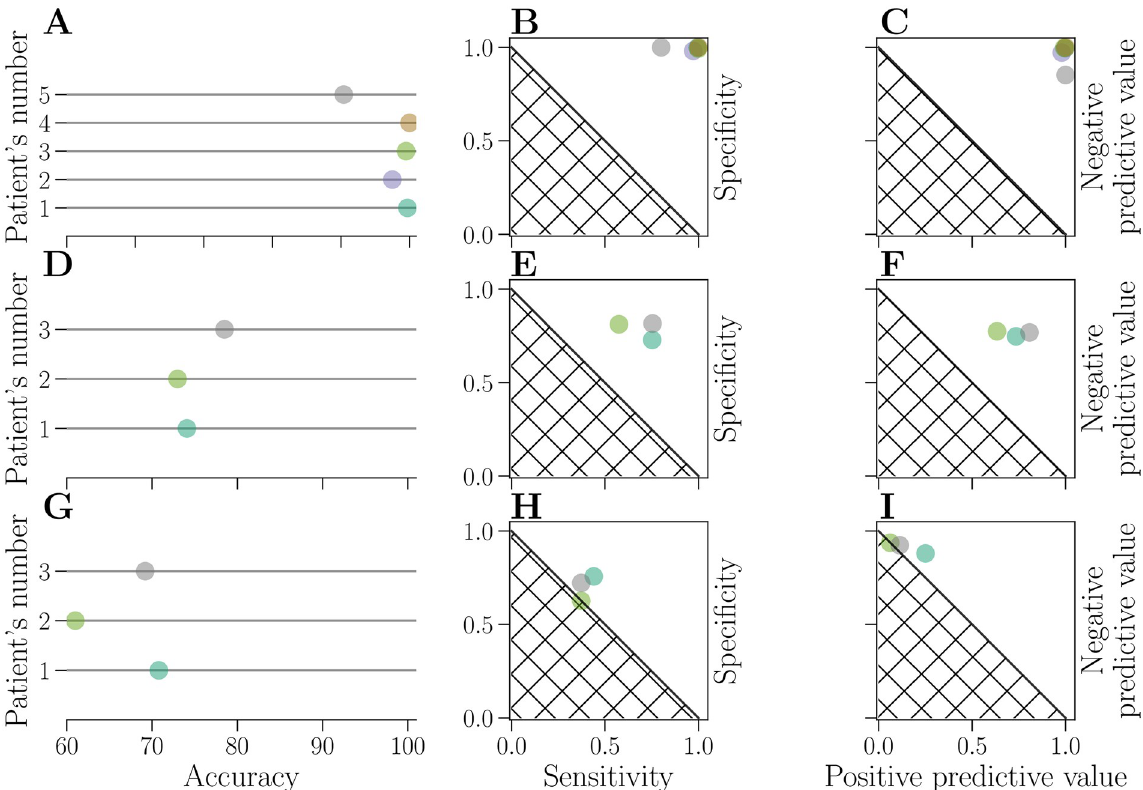
Fig 5. Evaluation of prediction performance. Results on the EPILEPSIAE dataset are shown in the upper row( A-C ). Results on the public Epilepsyecosystem are shown in the middle row ( D-F ) and the results on the private Epilepsyecosystem dataset (benchmark) are shown in the lower row ( G-I ). Performance of each patient is represented by a circle, for accuracy ( A , D , G ), specificity-sensitivity plot ( B , E , H ) and negative and positive predictive value ( C , F , I ). Identical colors are used to represent each patient across all nine subplots. The hatched area represents results attainable by a random classifier.